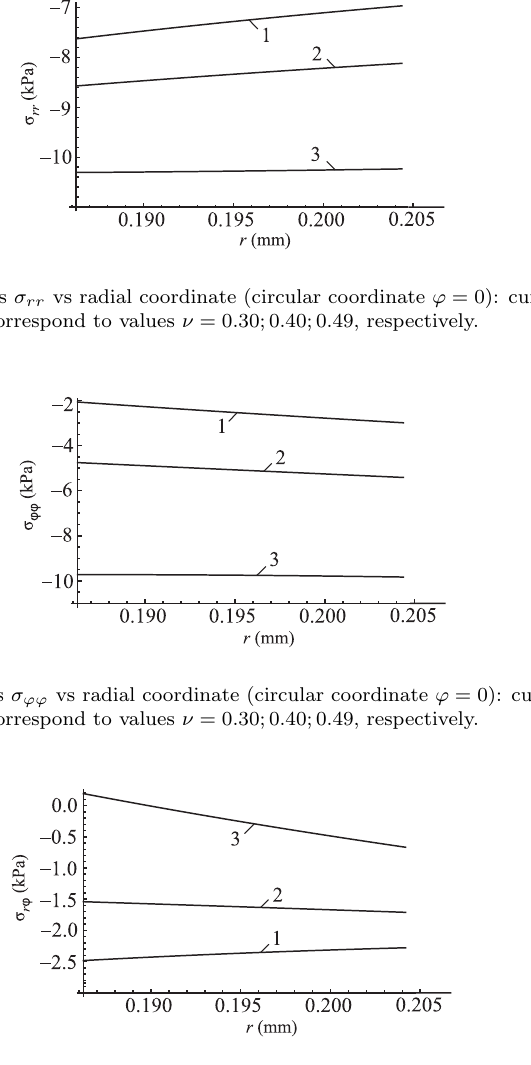
Figure 6. Stress σ rϕ vs radial coordinate (circular coordinate ϕ = π/ 2): curves 1, 2, 3 correspond to values ν = 0 . 30;0 . 40;0 . 49,